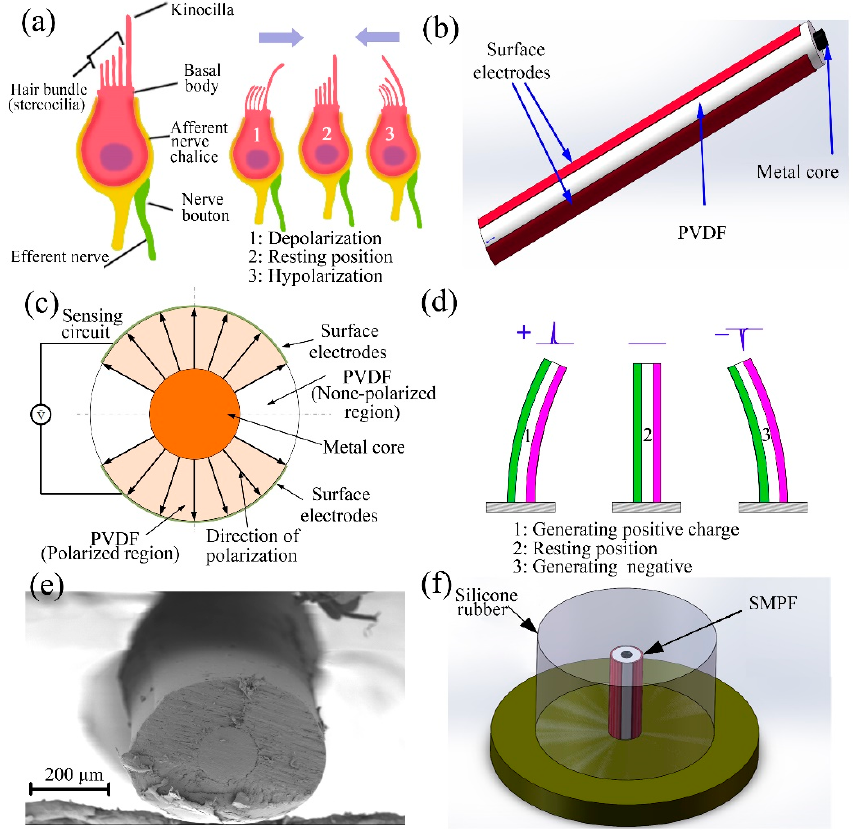
Figure 1. ( a ) Diagrams of the sensory cell and its sensing function for deformation. ( b ) Diagram of the SMPF structure. ( c ) The cross-section of the SMPF. ( d ) The sensing function for deformation. ( e ) A SEM image of the SMPF. ( f ) A diagram of the SMPF-R.